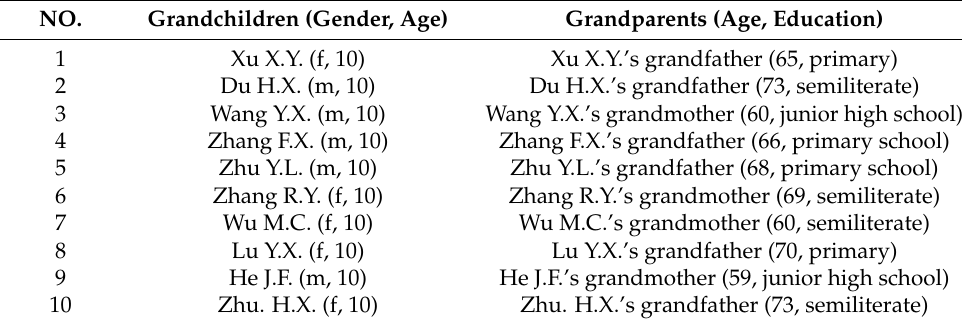
Table 1. Basic information about grandchildren and grandparents.